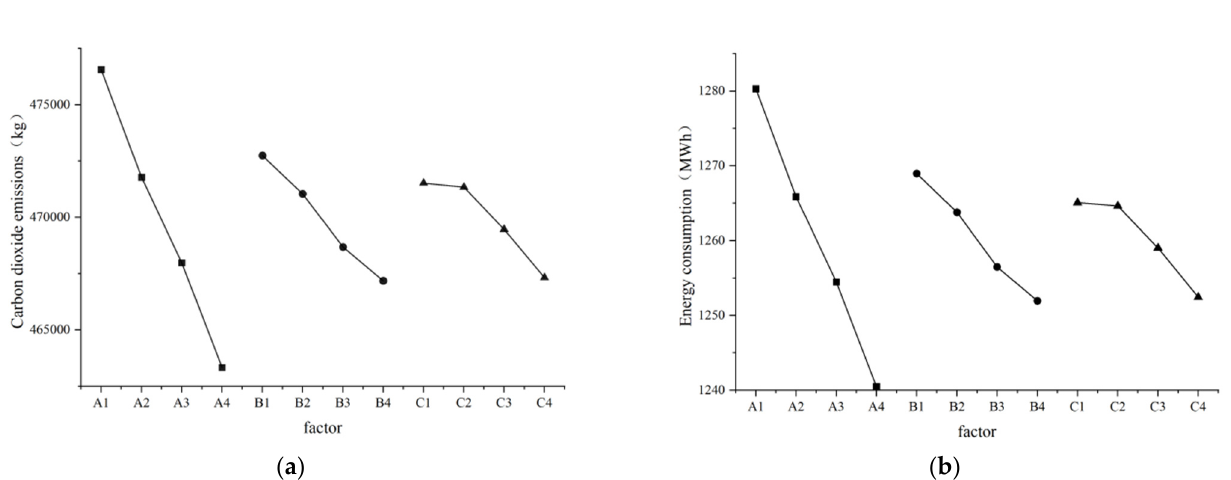
Figure 7. ( a ) Annual carbon emission effect graph; ( b ) annual energy consumption effect